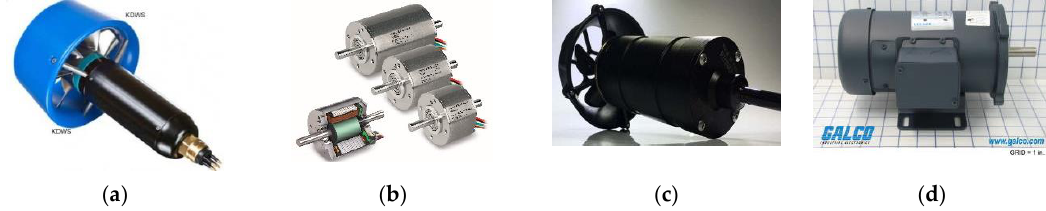
Figure 2. Representative Direct Current (DC) motors used as actuators for unmanned underwater vehicles (modeled in Equations (1) and (2) as described in [8]). ( a ) Marine Propeller DC motor [32]. ( b ) Unmanned Systems Technology DC motor [33]. ( c ) Maxon EC-i 40 DC motor [34]. ( d ) Galco Industries DC Motor [35].